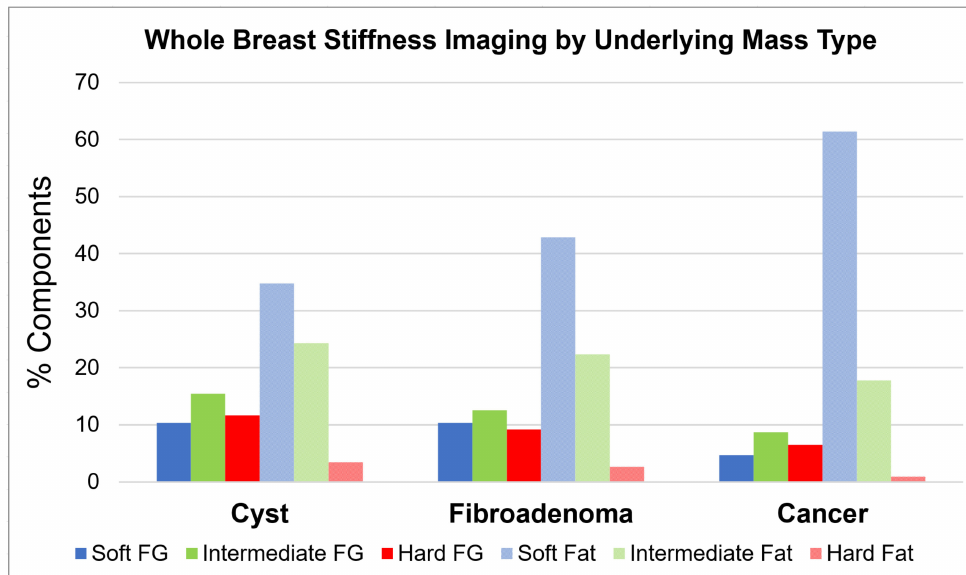
Figure 2. The six whole-breast stiffness components are separated into the three main patient groups according to their underlying masses. Fibroglandular tissues (darker bars) had greater percentages of the stiffest component (deeper red), while fatty tissues had softer components (lighter blue and green bars). SoftVue volumetrics also suggest overall greater percentage of fat for the large majority of patients with dense breasts in this series than by 2D assumptions, similar to volumetric assessments of mammographic breast density (e.g., Volpara, Volpara Health, Lynnwood, WA, USA). This may particularly affect the fat distribution of cancer patients since only patients with scattered breast density (i.e., more fat) had cancerous